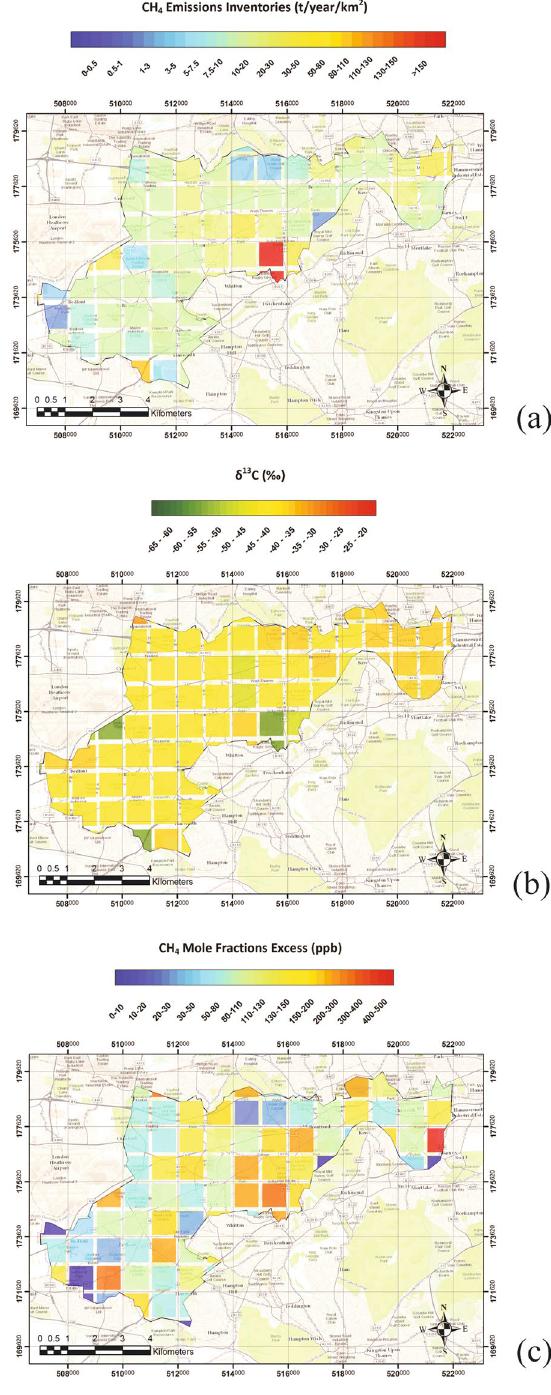
Figure 8. Map of the London borough of Hounslow ( a ) 2013 NAEI emission inventories ( b ) isotopic values calculated from 2013 emission inventories ( c ) values of mole fraction excess relative to the methane baseline in ppb, using measurements from four mobile surveys. The map was generated using ArcMap 10.2. Base map source: Sources: Esri, HERE, DeLorme, Intermap, increment P Corp., GEBCO, USGS, FAO, NPS,